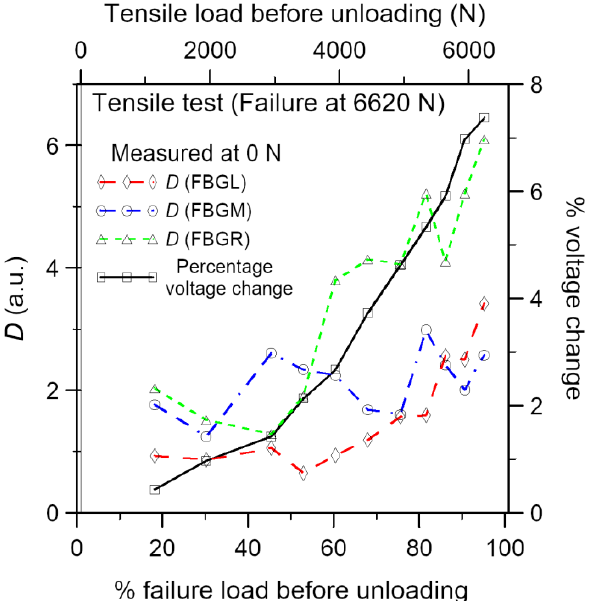
Figure 7. Load-free percentage voltage change and the three FBG spectra against the maximum load of the loading–unloading